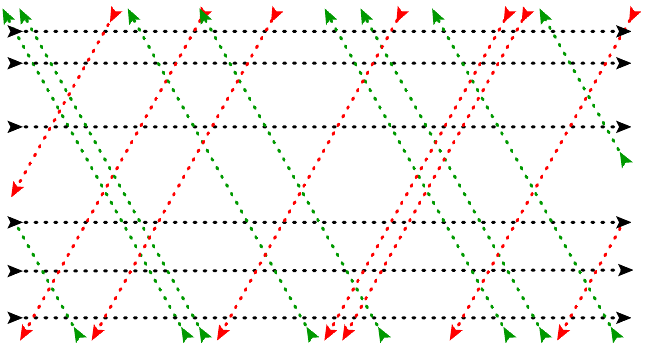
Figure 2 . General \dynamical" (cid:12)shnet bulk structure of a planar graph for 3-coupling chiral CFT (2.2). Dotted lines represent scalar or fermionic propagators (the rules for the choice of propagators will be explained below and demonstrated in (cid:12)gure 3) The colors and directions of the lines stand for the three \(cid:13)avours" of the particles i = 1 ; 2 ; 3 with the same notation as we used in (cid:12)gure 1. The intersections correspond to six di(cid:11)erent e(cid:11)ective vertices that can be written in terms of the usual ones following the map given in table